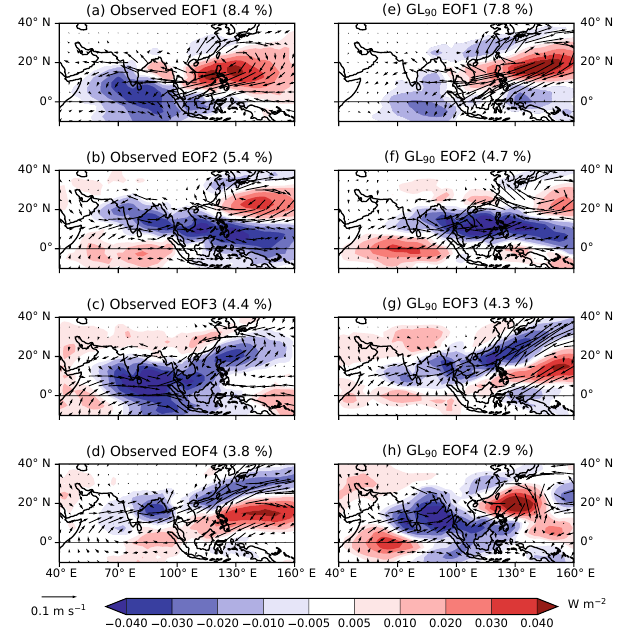
Figure 8. (a–d) MV-EOFs of OLR and u 850 calculated from AVHRR OLR and ERA-Interim u 850 using the method of Lee et al. (2013) (see their Fig. 2a, b and 3a, b). The meridional component of the wind plotted here was computed by regression onto the re- spective principal components. Figures in parentheses indicate the percentage of variance explained. (e–f) MV-EOFs calculated by the same method from GL 90 .